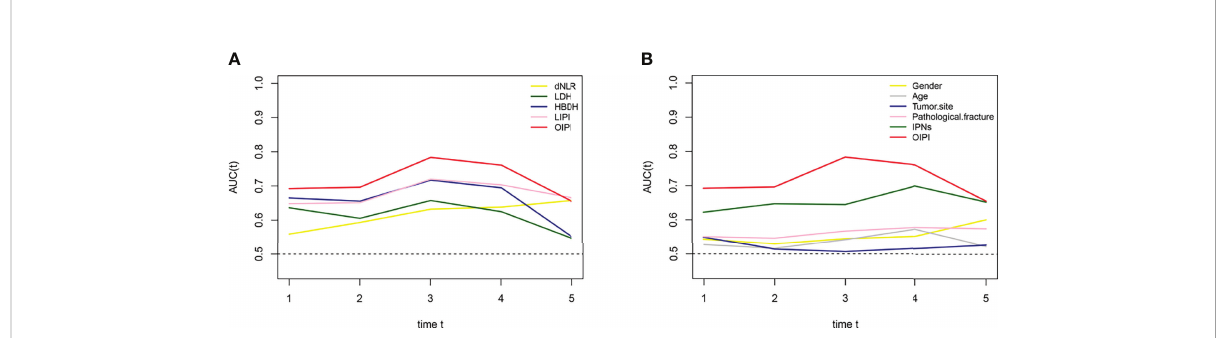
FIGURE 1 Comparison of different clinical biomarkers in predicting metachronous metastasis. (A) The difference in the predictive ability of different hematological markers is shown in the time-dependent ROC curve, in which a larger AUC value indicates a better metastatic predictive ability. (B) Difference in the predictive ability of different clinical features. dNLR, derived neutrophil-to-lymphocyte ratio; LDH, lactate dehydrogenase; HBDH, hydroxybutyrate dehydrogenase; LIPI, lung immune prognostic index; OIPI, osteosarcoma immune prognostic index; ROC, receiver operating curve; AUC, area under the curve; IPNs, indeterminate pulmonary nodules.